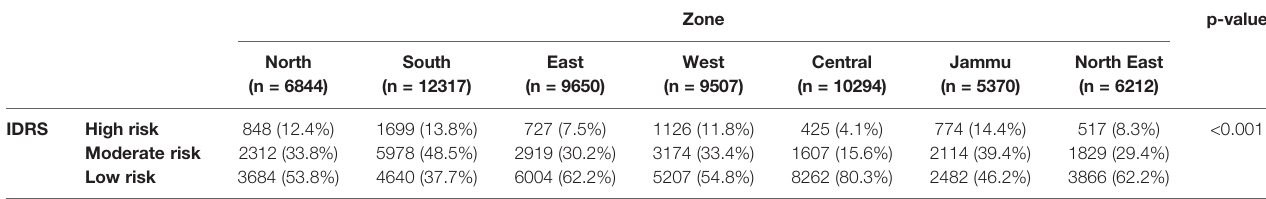
TABLE 3 | Zone-wise risk of diabetes based on IDRS score.